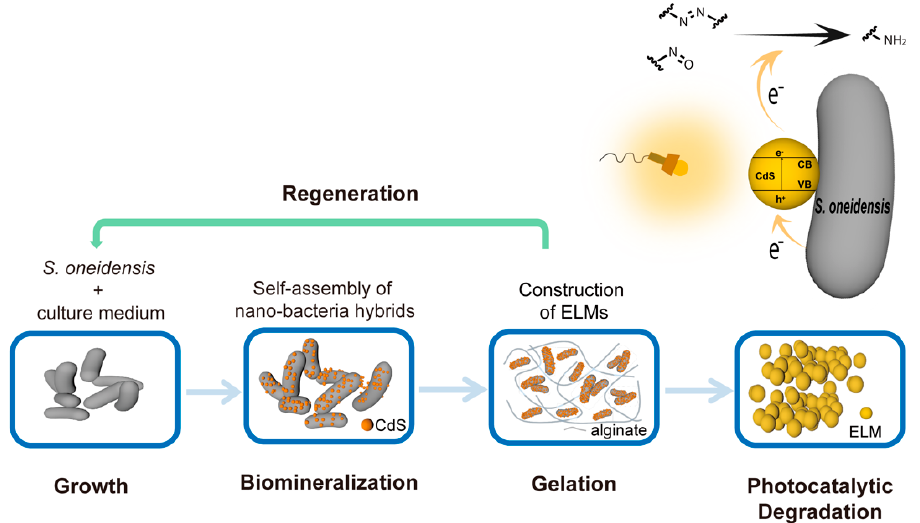
Figure 1. Schematic showing the workflow to construct engineered living materials (ELMs) with encapsulated nano-bacteria hybrids. The CdS nanoparticles biomineralized by Shewanella oneidensis are deposited on the surface of cells to self-assemble nano-bacteria hybrids. The hybrids are encapsulated in an alginate hydrogel containing nutrients to form ELMs. Nano-bacteria hybrids in the ELMs can remove contaminants via photocatalytic reductive degradation.